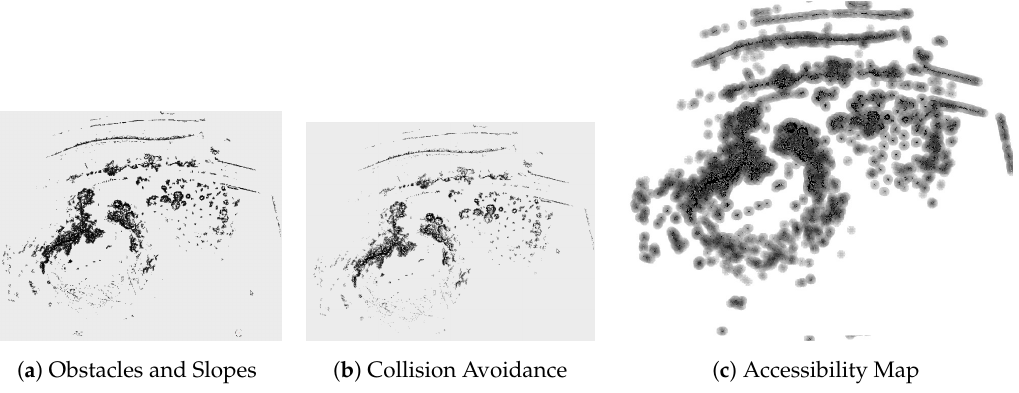
Figure 9. Result of Map Accessibility